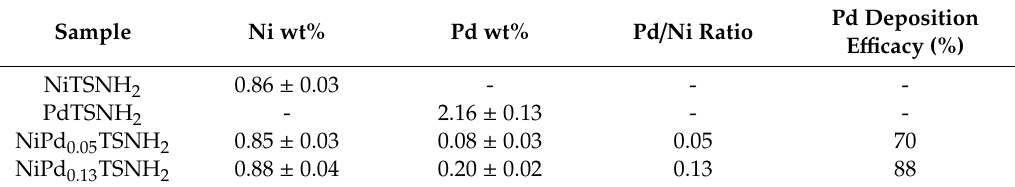
Table 3. Ni and Pd content in the monometallic and bimetallic catalysts